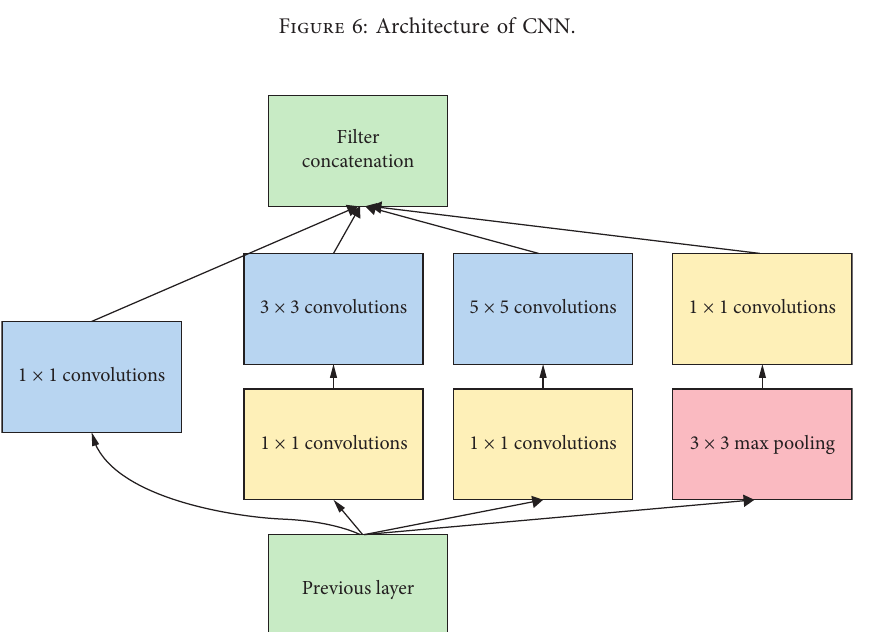
Figure 6: Architecture of